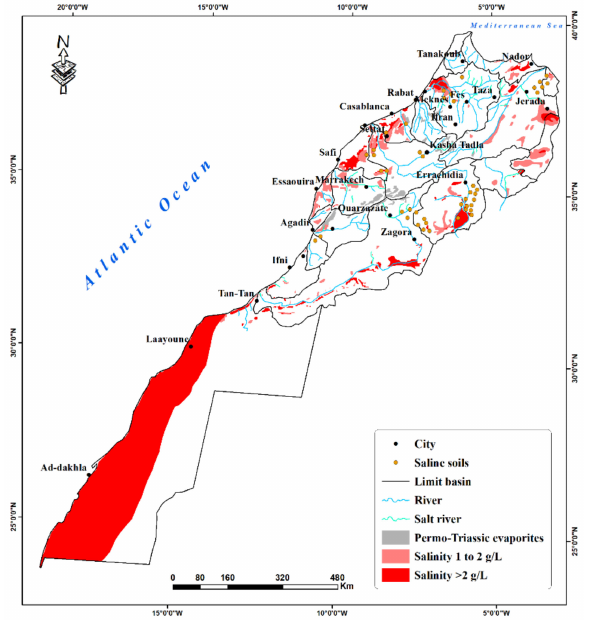
Figure 1. Spatial distribution of saline soil, aquifers and rivers in Morocco, modified from [4].